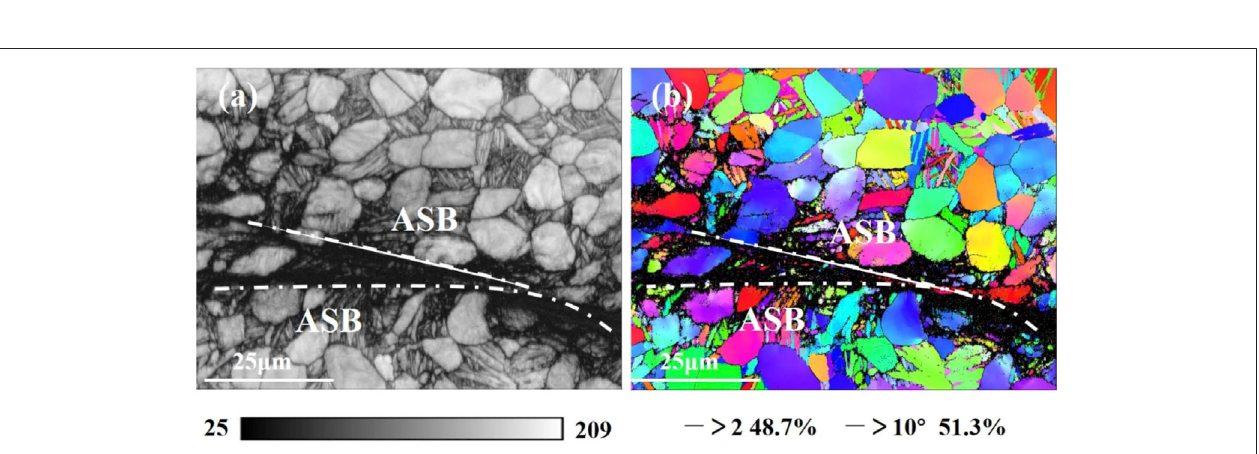
FIGURE 10 | The microstructure of the bottom corner position of shear region in left side of specimen obtained at the strain rate of 1.8 × 10 4 s − 1 , (A) BC map; (B) IPF coloring.